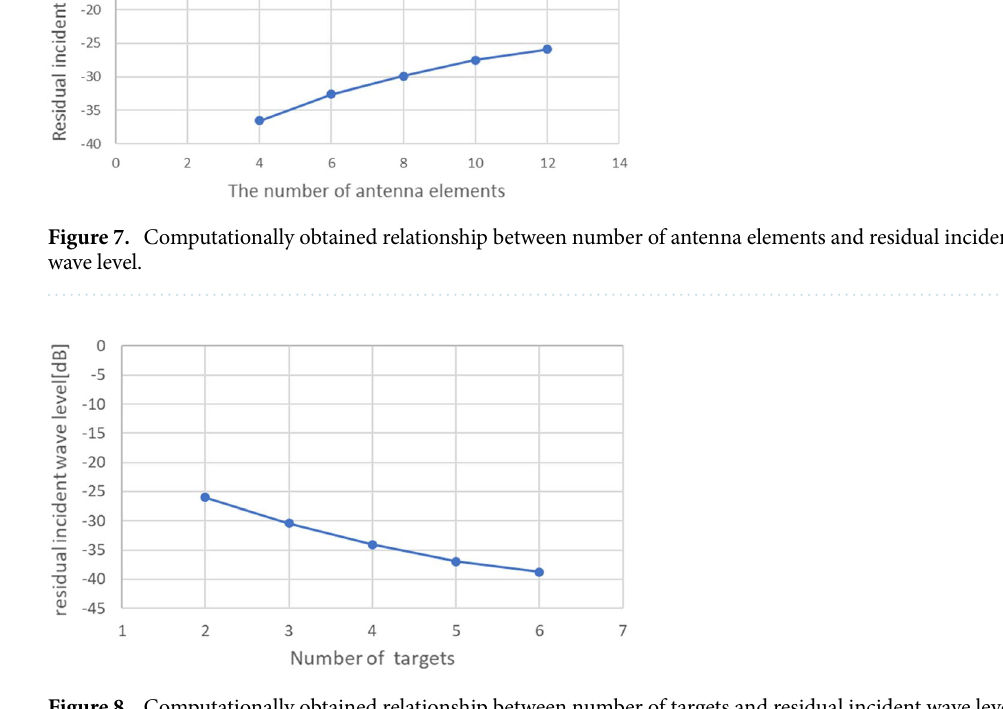
Figure 8. Computationally obtained relationship between number of targets and residual incident wave